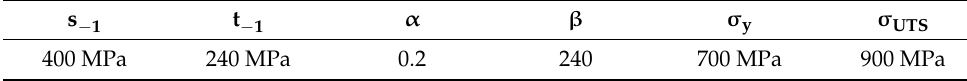
Table 1. Material properties at macroscopic scale.